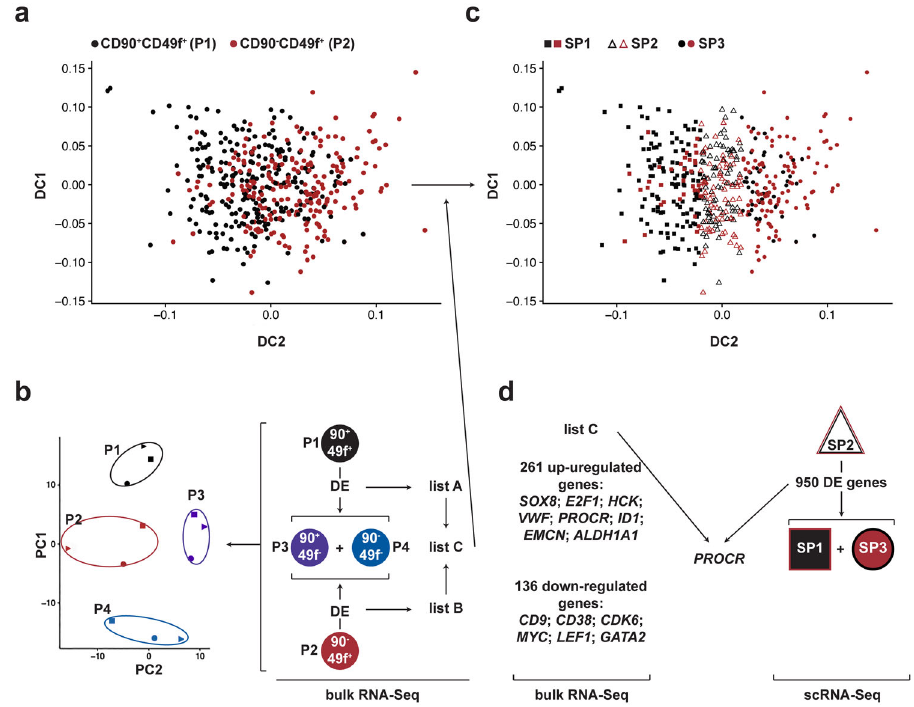
Fig. 2 Transcriptomic studies identify EPCR as a potential selection marker for the repopulating cells within both CD90 + CD49f + and CD90 − CD49f + populations. a Diffusion map representation of the single cell data generated from 469 QC-passed single CD90 + CD49f + (P1) and CD90 − CD49f + (P2) cells. b Two-dimensional representation of the bulk RNA-seq performed in the four populations ( n = 3) by principle component analysis (PCA). DE analyses were performed with the indicated populations: CD90 + CD49f + (P1) vs ((CD90 + CD49f − (P3) + CD90 − CD49f − (P4)) and between CD90 − CD49f + (P2) vs ((CD90 + CD49f − (P3) + CD90 − CD49f − (P4)) and we refer to the respective gene sets as lists A and B. c Diffusion map representation of the single cell ( n = 469) data shown in a after the inferred internal cell state was guided by the total RNA-seq data via list C resulting in 3 sub-populations (SP1, SP2, and SP3). d Work fl ow analysis of the total and scRNA-seq data (Supplementary Data 2 and 3 for details). Source data are provided as a Source Data fi